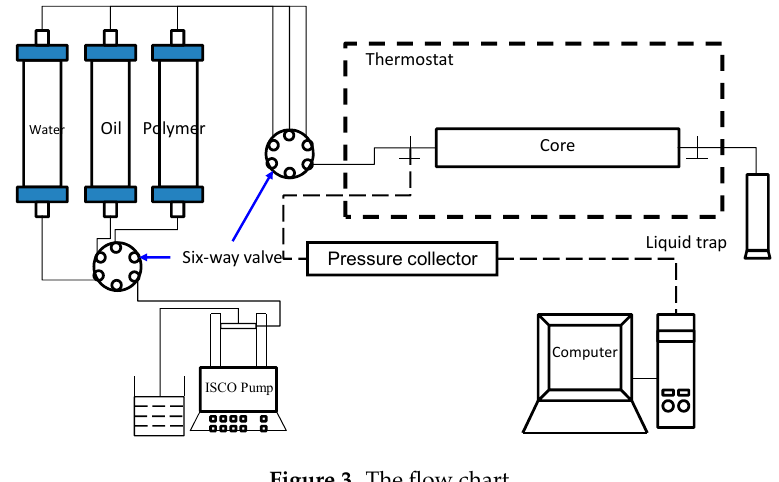
Figure 3. The flow chart.